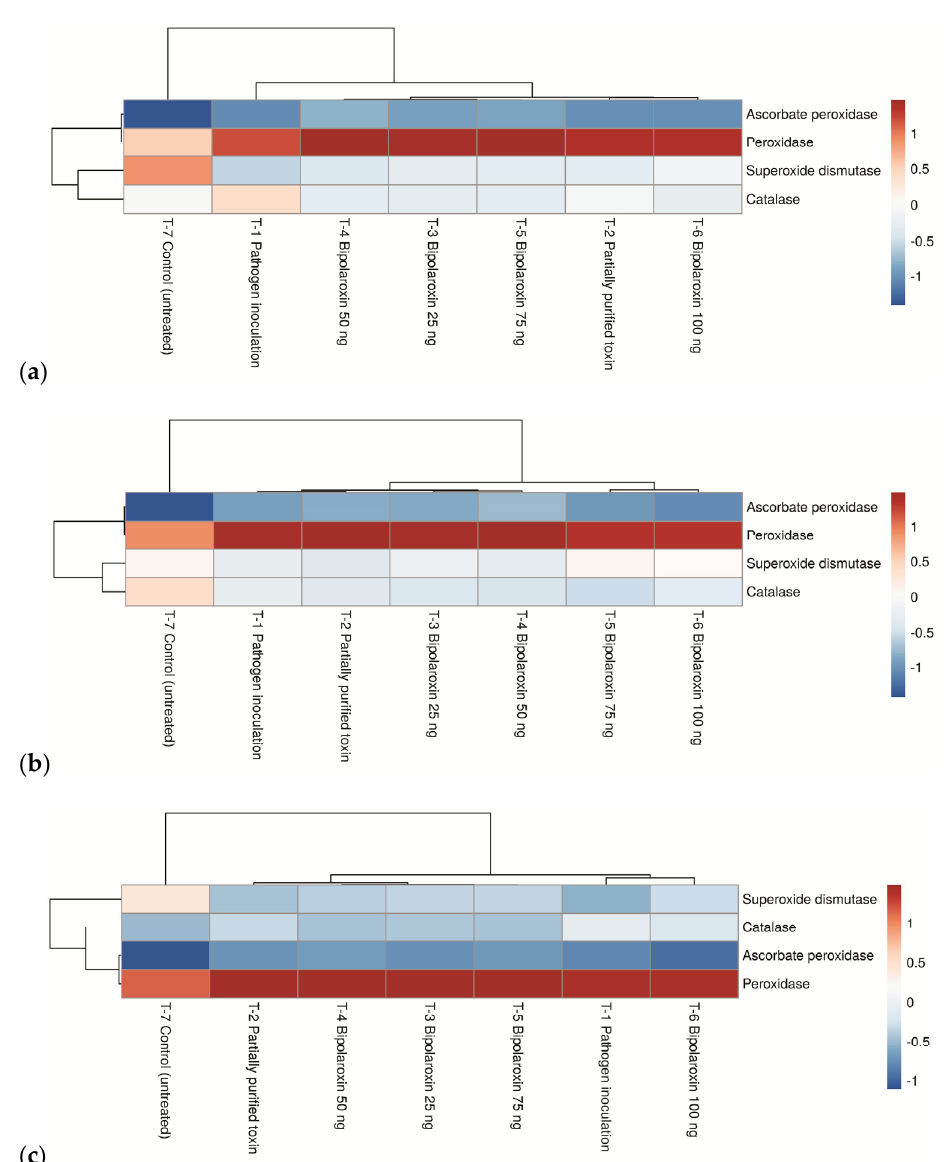
Figure 13. Expression profile of antioxidant genes in susceptible line, Agra Local ( a ) and resistant lines, Chinese Spring ( b ), and Chirya3 ( c ) under pathogen inoculation and infiltration of partially purified toxin obtained from B. sorokiniana as well as chemically synthesized Bipolaroxin at 7 days of inoculation/treatments under glasshouse conditions.